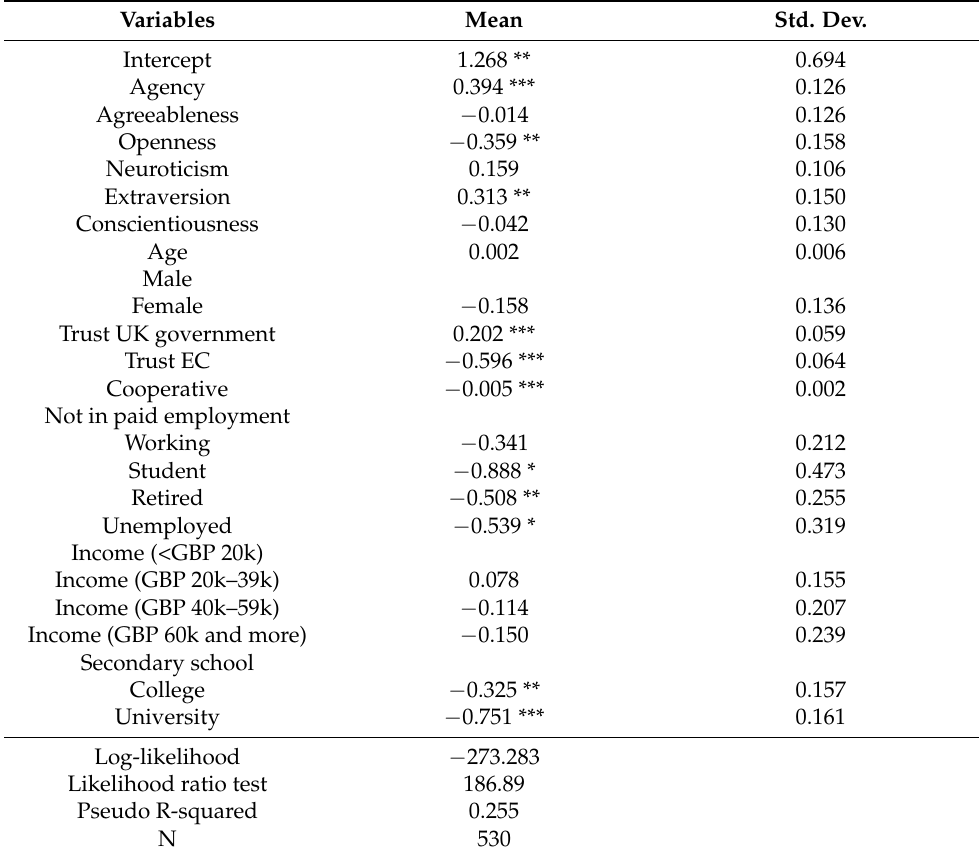
Table 3. Determinants of voting for the UK leaving the